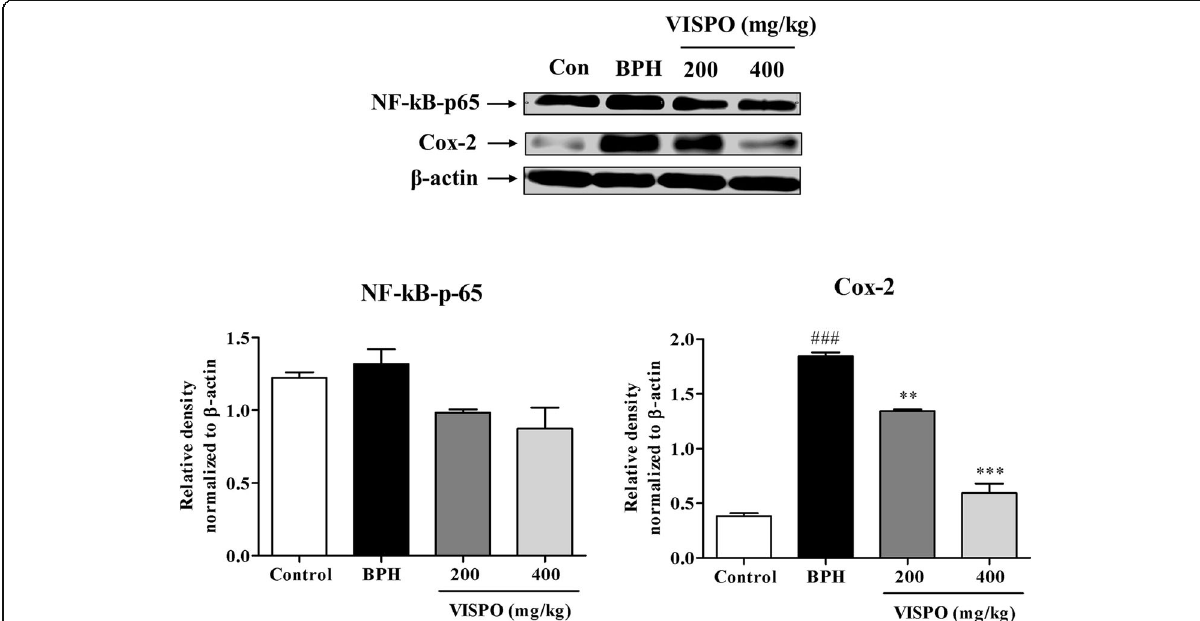
Fig. 5 Effect of VISPO administration on the expression of NF-kB and Cox-2 in prostate tissue of BPH model rats. The protein expression was determined by western blotting using specific antibodies. β -actin was used as loading control. Densitometric analysis was performed using Image